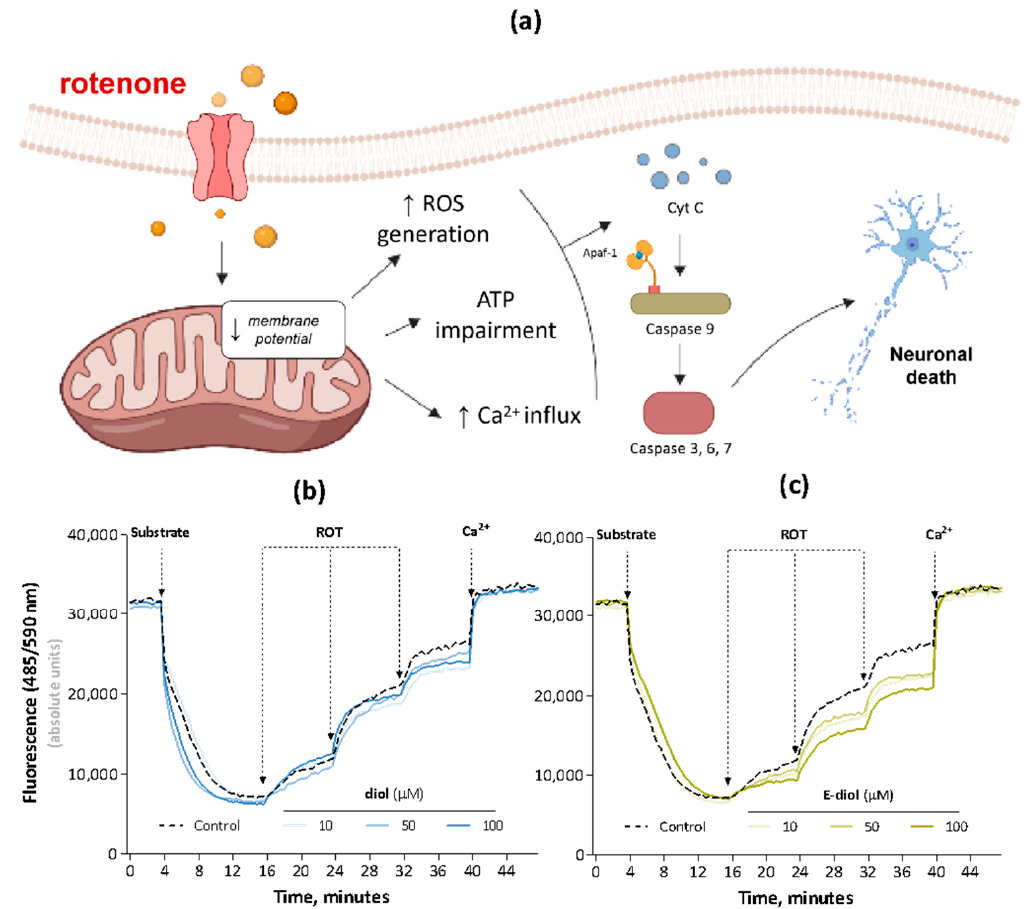
Figure 4. Schematic representation of the rotenone effect on the mitochondrial transmembrane po- tential, leading to the death of neuronal cells ( a ). Evaluation of the mitochondrial membrane poten- tial using the fl uorescent lipophilic cation safranin O. The e ff ect of diol ( b ) and epoxidiol ( c ) in the concentration range from 10 µM to 100 µM on the transmembrane potential of rat liver mitochondria (0.5 mg/mL) in the rotenone presence at a concentration of 10 nM. Energization of organelles was carried out by substrates of the electron transport chain I complex—glutamate/malate (5 mM). The achievement of complete depolarization was stimulated by Ca 2+ ions (25 µM). The data are pre- sented as kinetic curves of changes in the mitochondrial membrane potential (mean ± SEM).